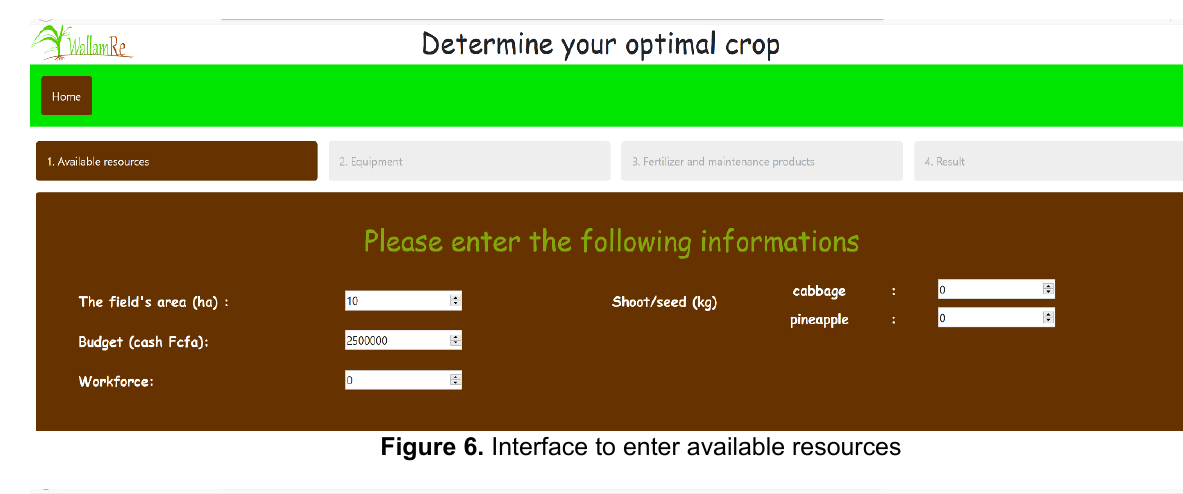
Figure 6. Interface to enter available resources